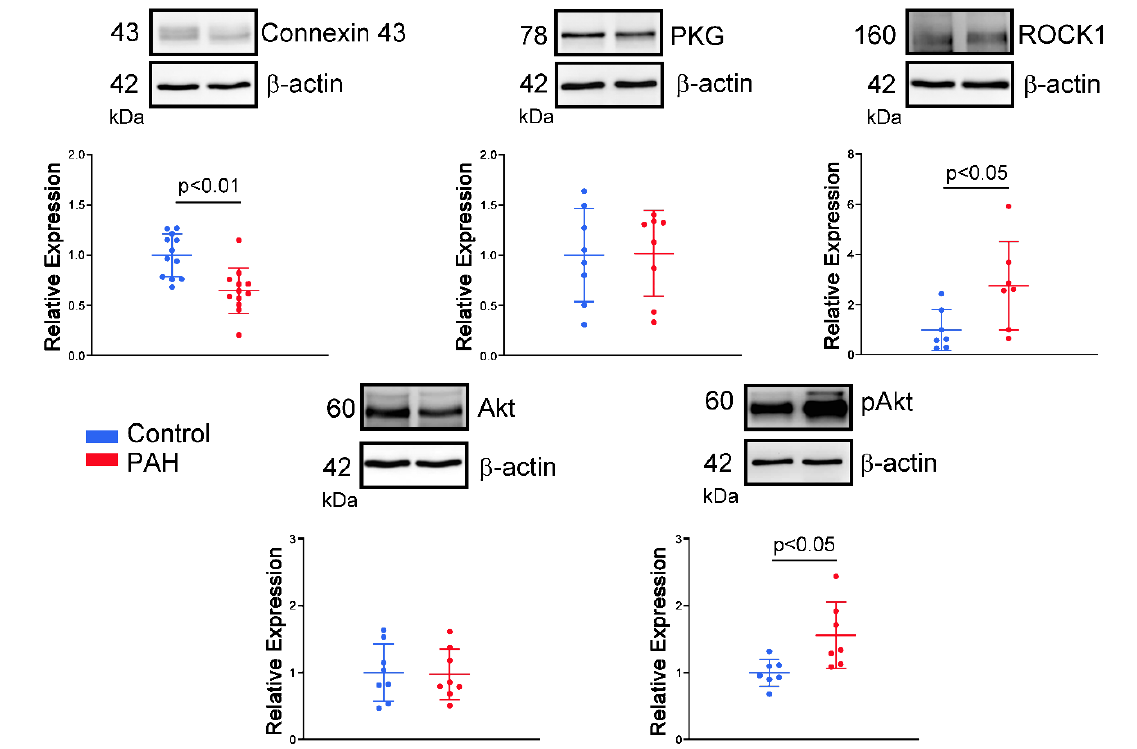
Figure 7. Western blot analysis of connexin 43, protein kinase G (PKG), RhoA/Rho kinase 1 (ROCK1), Akt and phosphorylated Akt (p-Akt) of right atrium (RA) tissue from control rabbits or rabbits with monocrotaline (MCT)-induced pulmonary arterial hypertension (PAH). Representative images and the relative expression of connexin 43 (N = 12), PKG (N = 8), ROCK1 (N = 7), Akt (N = 8), p-Akt (N = 7) in the control and MCT-induced PAH groups. Data are presented as the mean ± standard error of the mean.